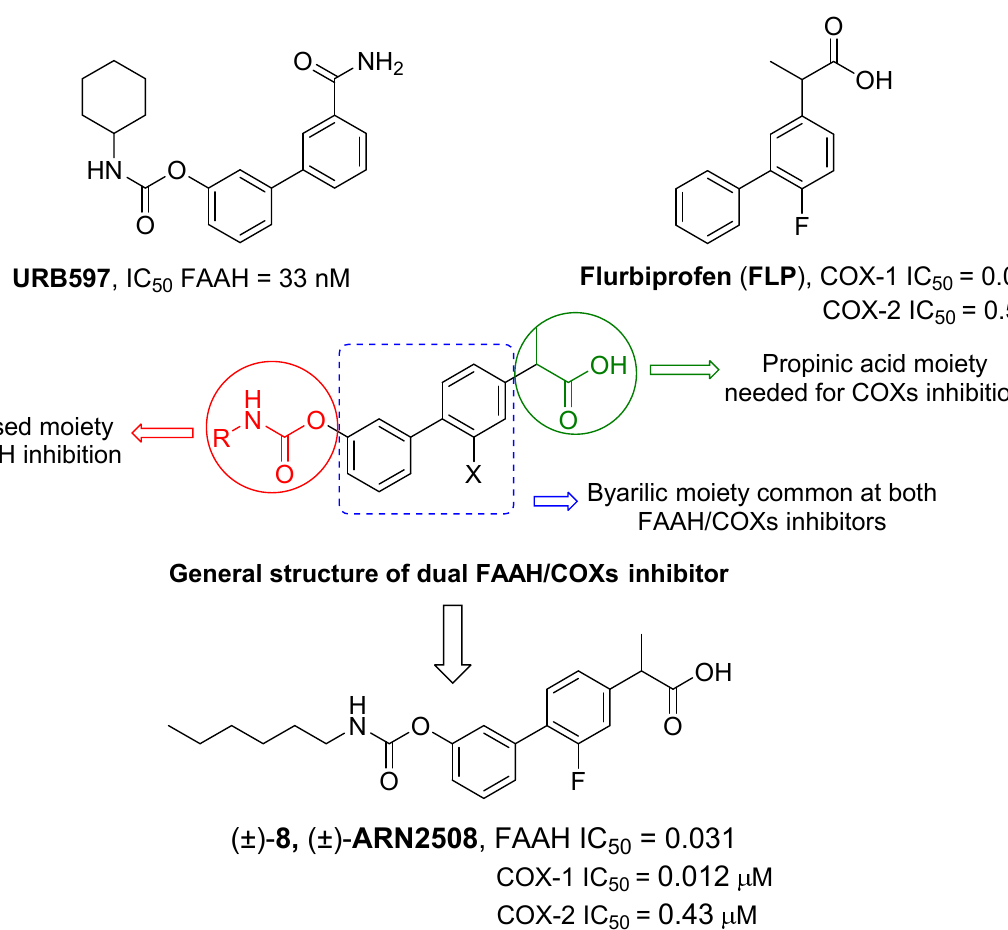
Figure 2. Representation of rational development of dual FAAH/COXs inhibitor (±)-ARN2508 (±- 8 ) starting from FAAH inhibitor URB597 and COXs inhibitor flurbiprofen (FPL).